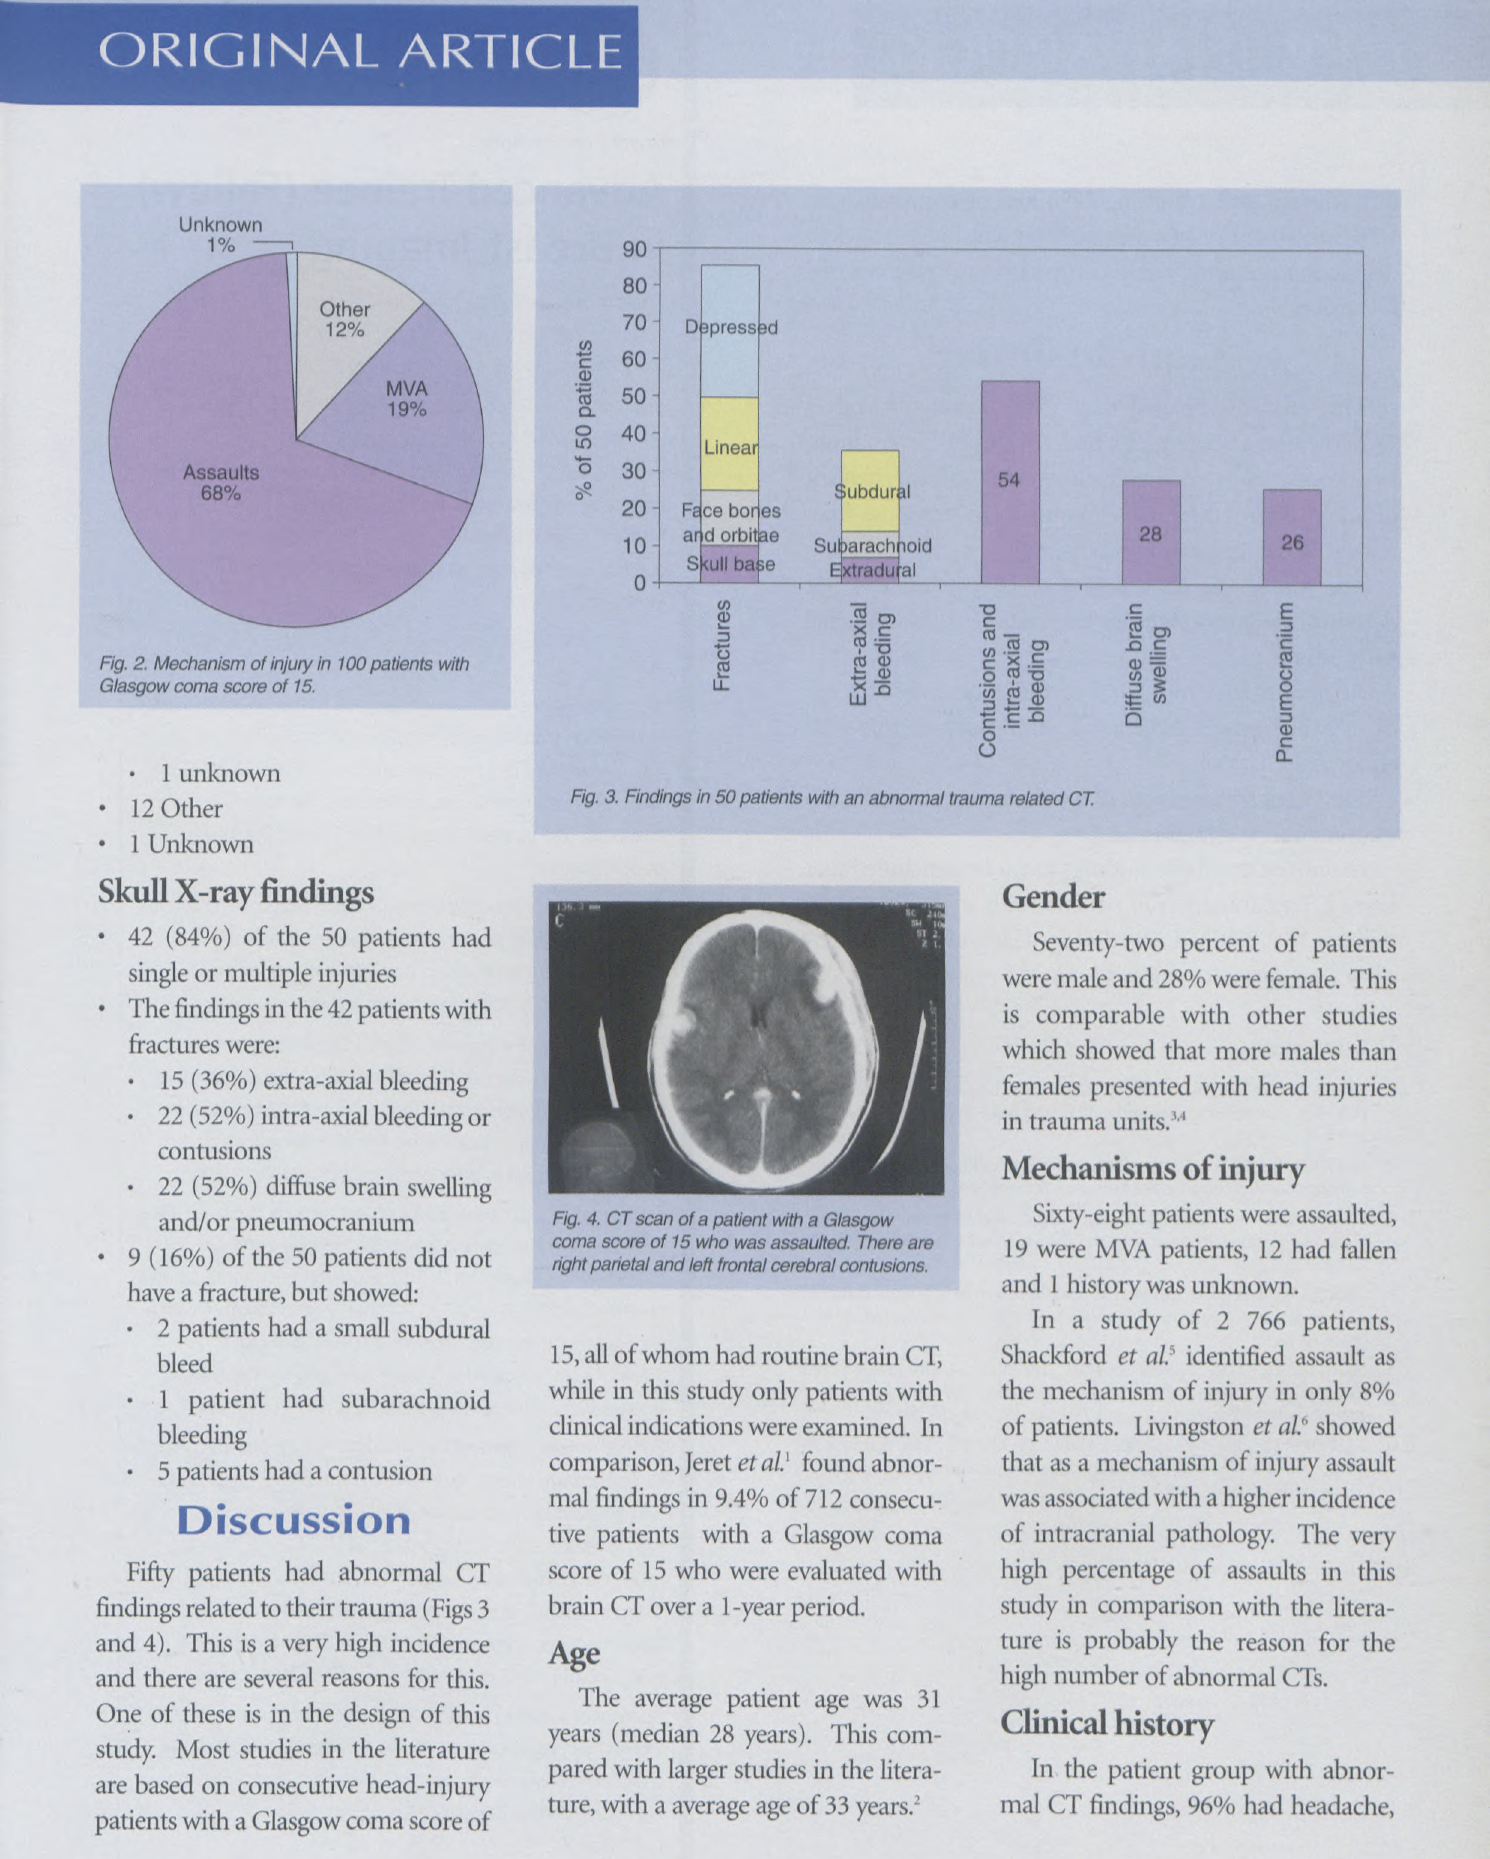
Fig. 4. CT scan of a patient with a Glasgow coma score of 15 who was assaulted. There are right parietal and !eft fronta! cerebra!